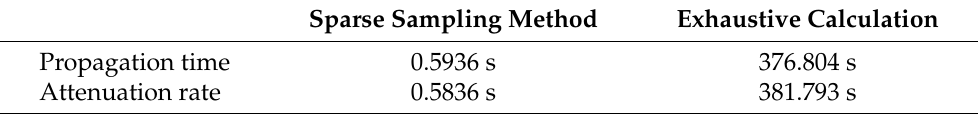
Table 3. Comparison of calculation time.